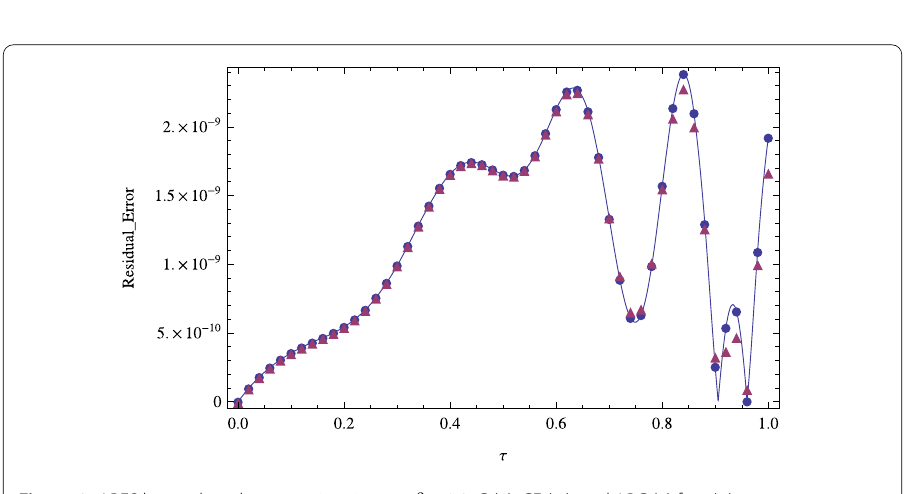
Figure 8 ARES by tenth-order approximations at β = 0.8, C ( • ), CF ( (cid:2) ), and ABC (–) for x ( τ